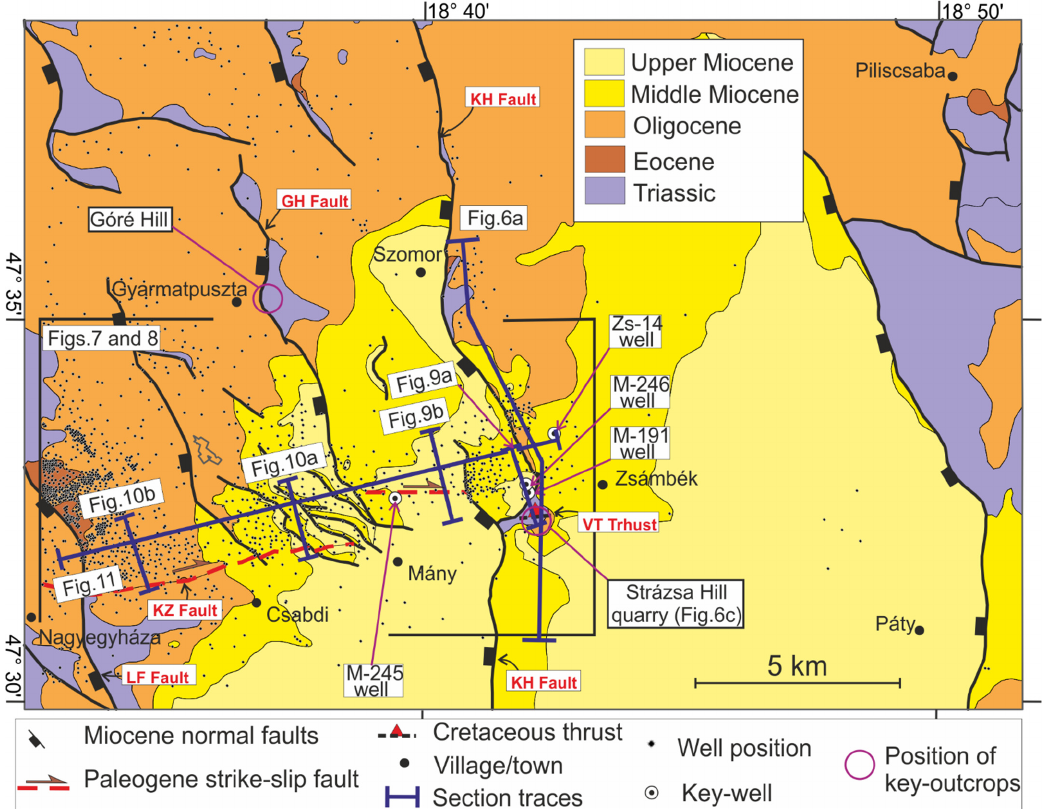
Figure 4. Position of well data and cross-sections on the pre-Quaternary geological map of the Zsám- bék-Mány Basin. For the position of the map within the northeastern part of the Transdanubian Range, see Figure 2. Abbreviation of the faults: GH Fault: Góré Hill Fault; KH Fault: Kakukk Hill Fault; LF Fault: Lófingató Hill Fault; KZ Fault: Környe-Zsámbék Fault. The abbreviations “Fig.” refer to figures of this work.